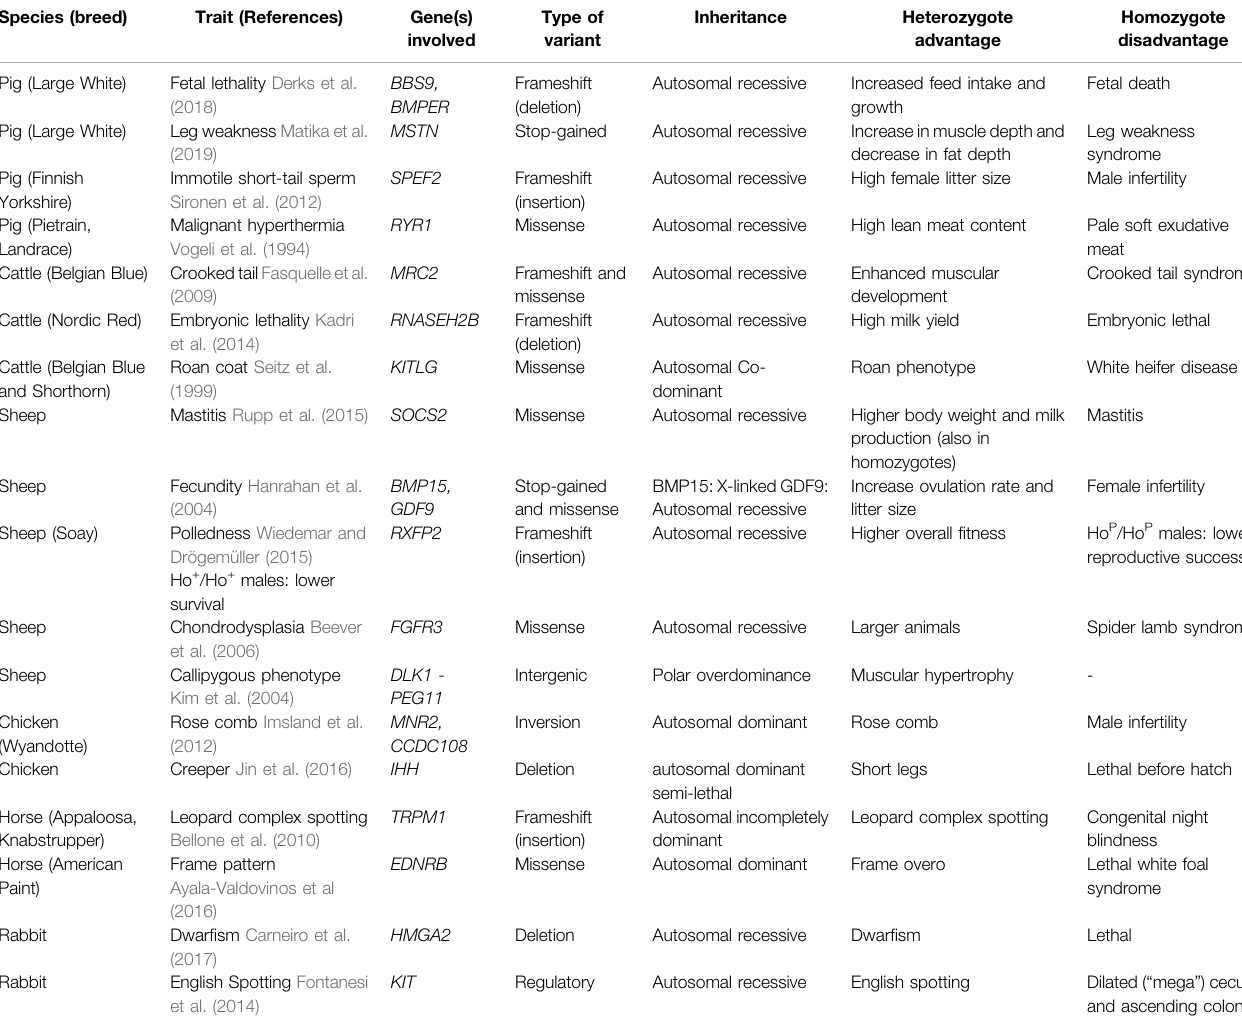
TABLE 1 | An overview of the 18 examples of alleles with a heterozygote advantage and a homozygote disadvantage in livestock species. Species (breed)